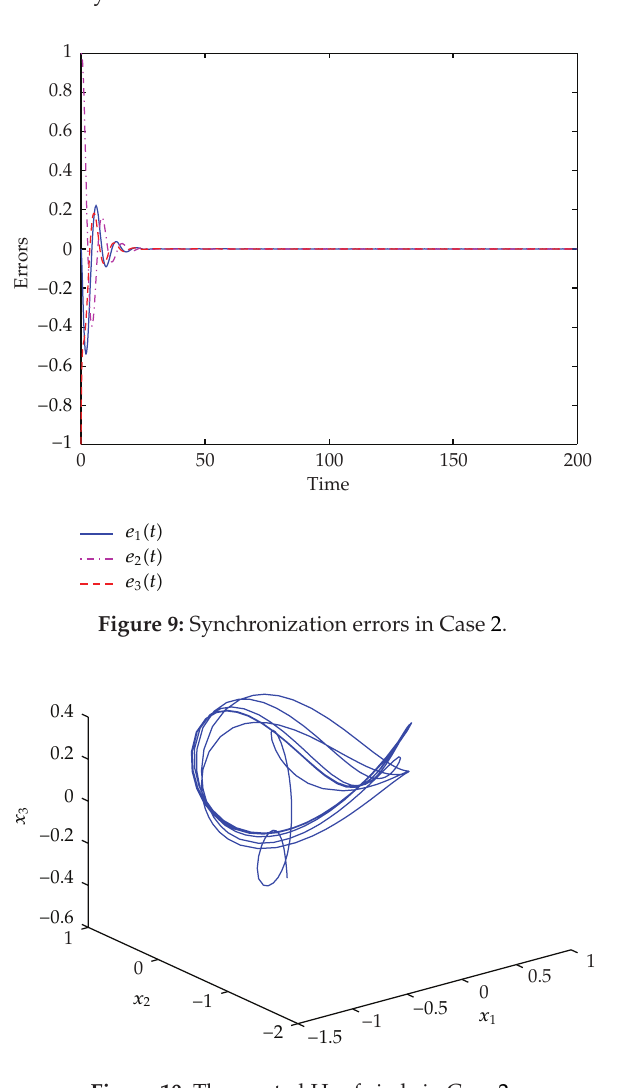
Figure 10: The created Hopf circle in Case